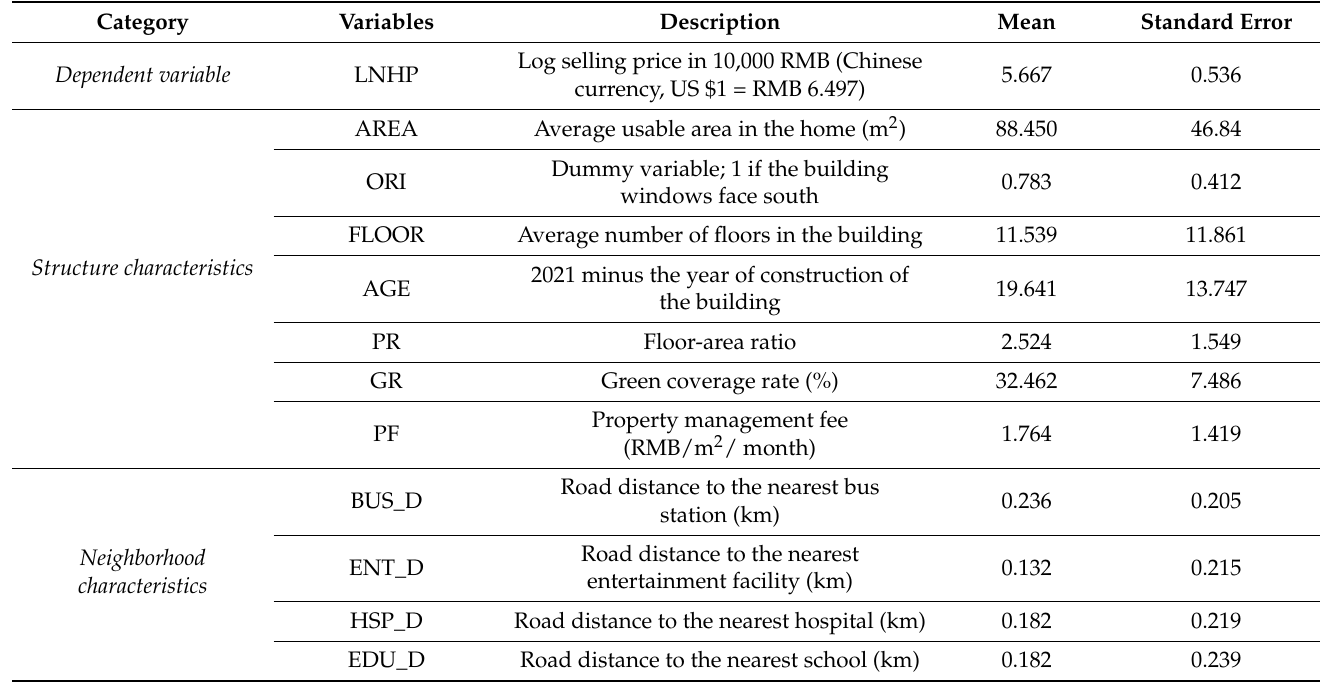
Table 1. Characteristic indicators and basic